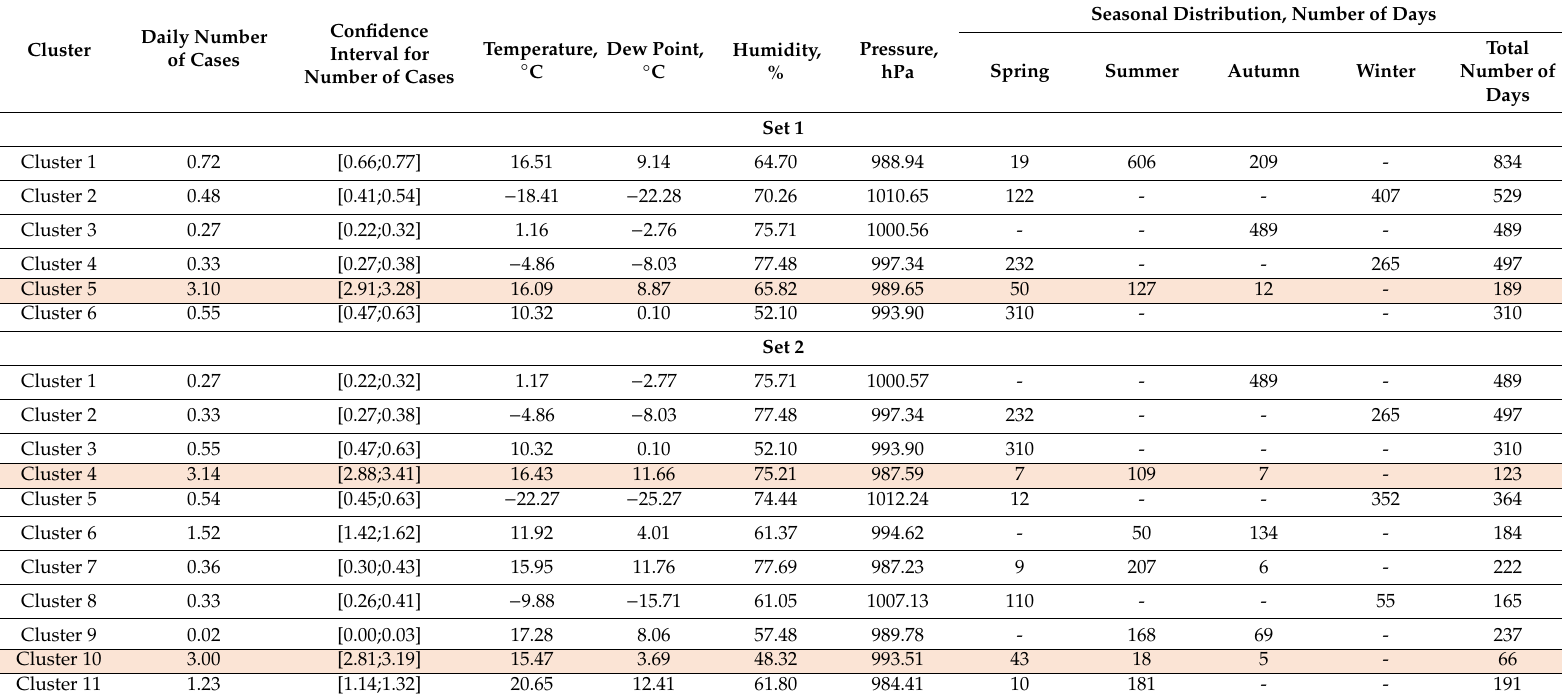
Colored rows refer to clusters with the high disease